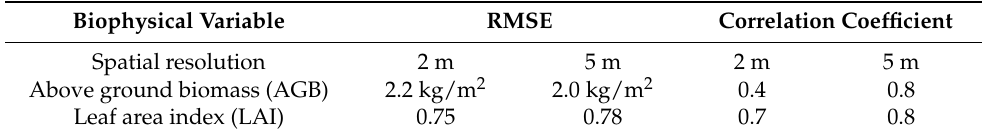
Table 4. Root mean square errors (RMSEs) and correlation coefficients (r) for above ground biomass and leaf area index maps with respect to the validation